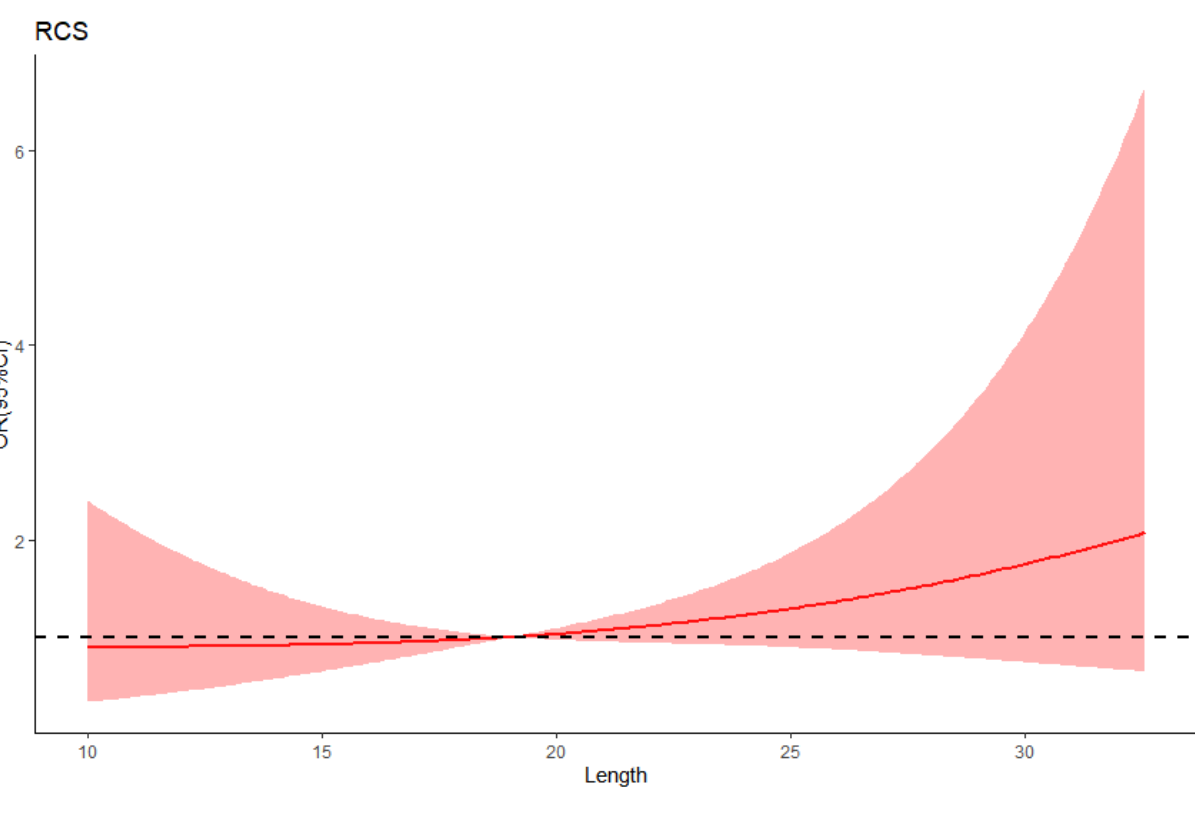
Figure 3. The relationship of the length of EV/CN and the risk of delayed RLS. The reference line for no association is indicated by a dashed black curve at a odds ratio of 1.0. The intersection of the dashed black curve and solid red curve represents the cut-off value of the length of EV/CN (19 mm). The light red area showing 95% confidence intervals derived from restricted cubic spline regressions. CN = Chiari Network; EV = Eustachian valve; RLS= right-to-left shunt; RCS= restricted cubic spline.